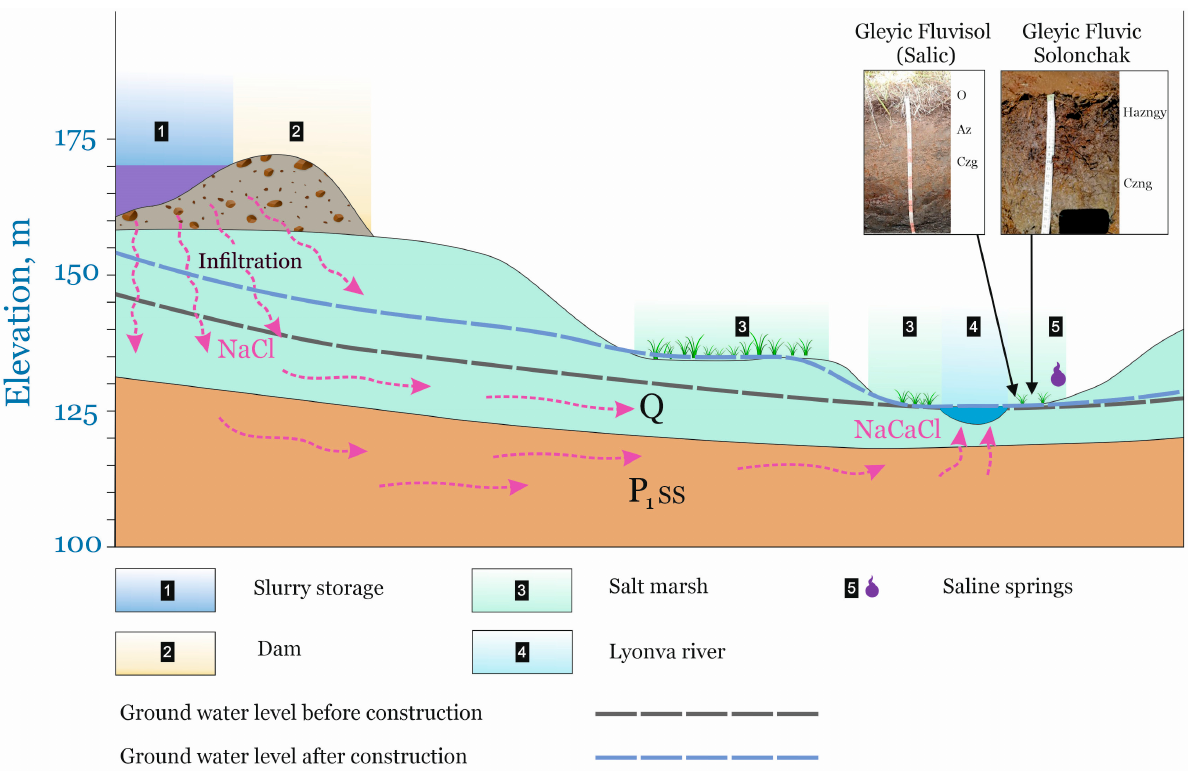
Figure 6. Cross section of the Lyonva River valley illustrating the multi-process formation of saline soils. Table 1. Water chemistry in the vicinity of the slurry storage site